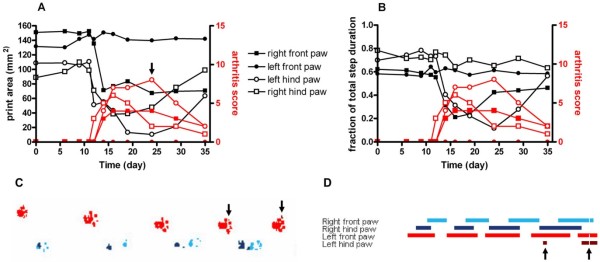
Gait analysis by CatWalk in an arthritic rat. Time course of the print area (A) and the duration of stance phase measured as the fraction of total step duration (B) of all four paws in a nine-week-old female pristane-treated rat walking across the CatWalk walkway. Front paws are shown with filled symbols, hind paws with open symbols. The left side is shown with circles, the right side with squares. Gait parameters are depicted in black, arthritis score in red. (C) Picture of CatWalk footprints on Day 24 after injection of 150 μl pristane oil. Prints of the left paws of the rat are shown in red, and prints of the right paws are shown in blue. Prints of front paws are depicted in lighter colour, whereas prints of the hind paws are darker. (D) Picture of the CatWalk gait diagram 24 days after pristane-injection. Indicated are the paw-floor contacts for each of the paws over time. The length of each bar represents the duration of the stance phase for that particular paw. The space between bars represents the duration of the swing phase. Decreases in print area as well as in the stance phase in the arthritic paws are observed (arrows).